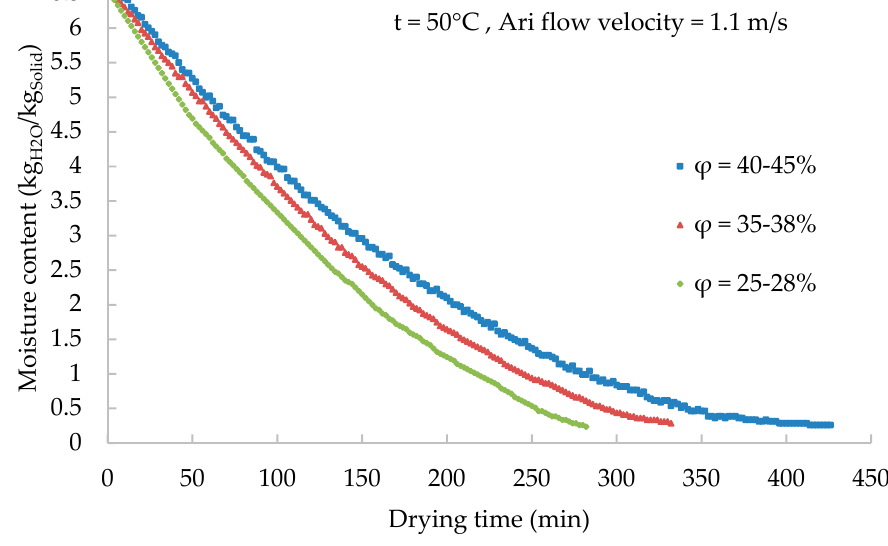
Figure 5. E ff ect of air relative Figure 5. Effect of air relative humidity.